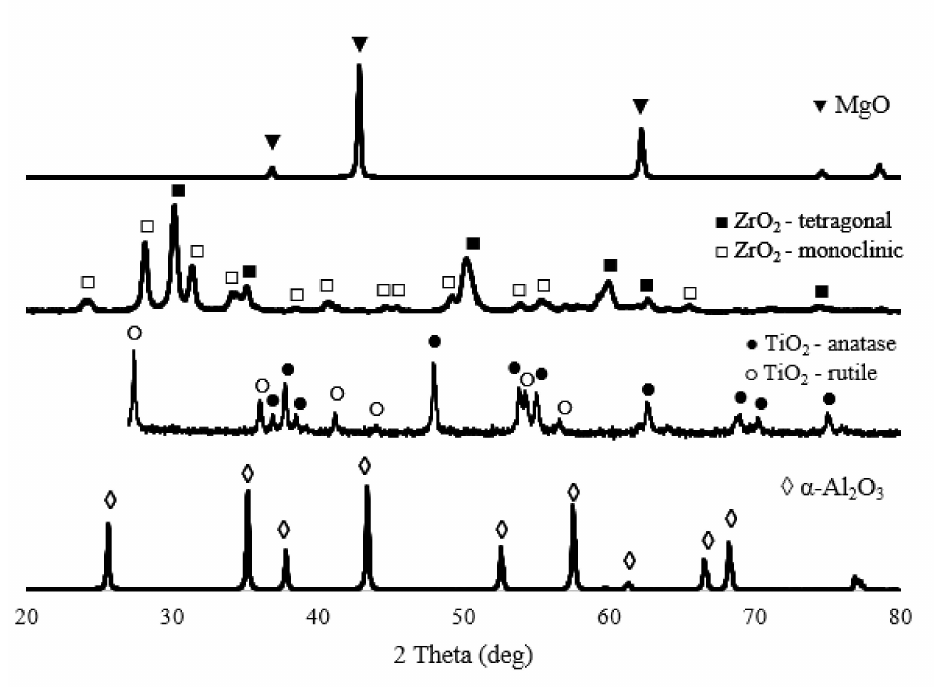
Figure 1. XRD patterns of